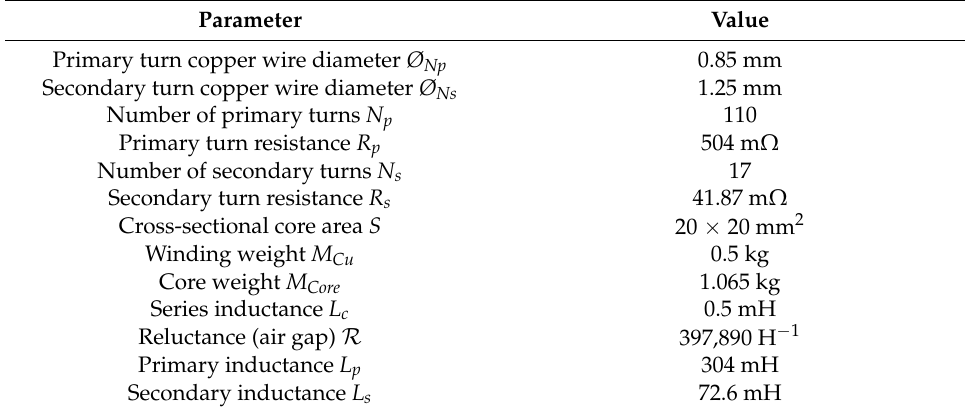
Table 3. Autotransformer 12-pulse rectifier